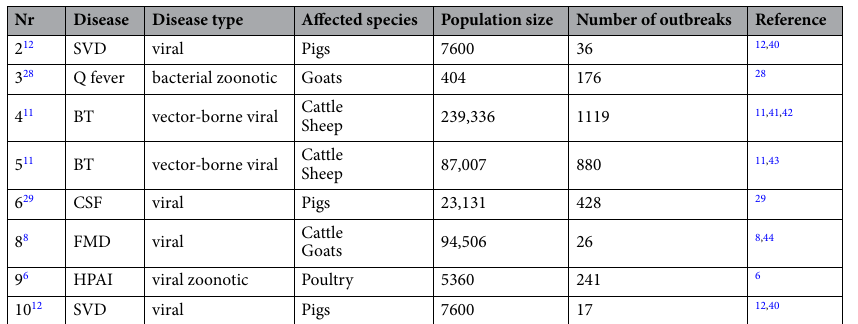
Table 2. Basic characteristics of eight epidemics/epidemic datasets analyzed. For further details we refer the reader to the original publications on these datasets.